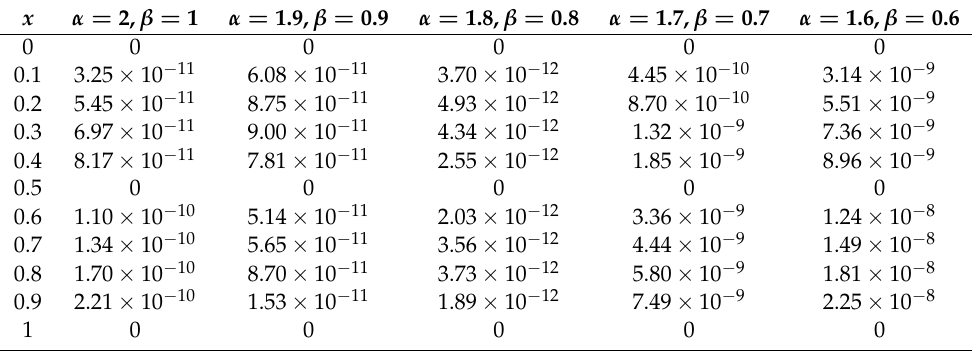
Table 1. Comparison of absolute error of Example 1 for various α , β ( m = 3, n = 3).